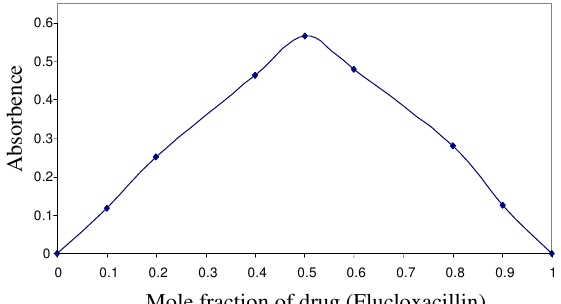
Figure 2. Jobs plot for stoichiometric ratio between flucloxacillin and iodine (2.03 × 10 -4 M each).